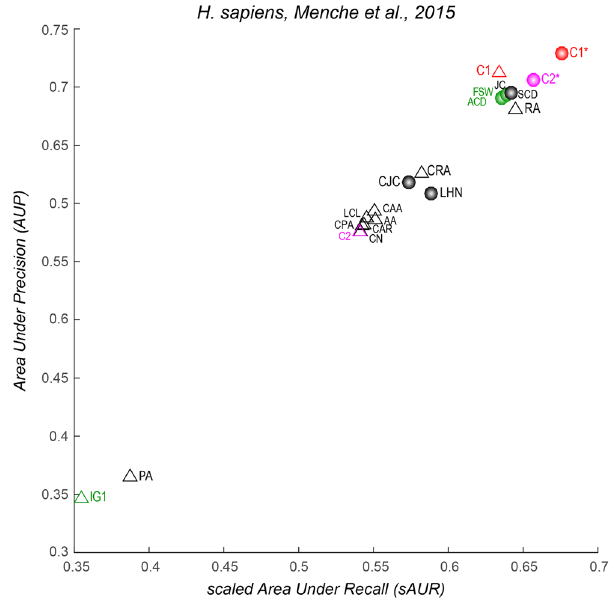
Figure 7. Performance evaluation in network 10. Different colours are used to distinguish: the classical network science reliability models (black); the traditional network biology models (green); the two new local- community models based on the rule C1 and its normalized version C1 * (red); the two new local-community models based on the rule C2 and its normalized version C2 * (magenta). The triangle symbol is adopted to mark the non-normalised